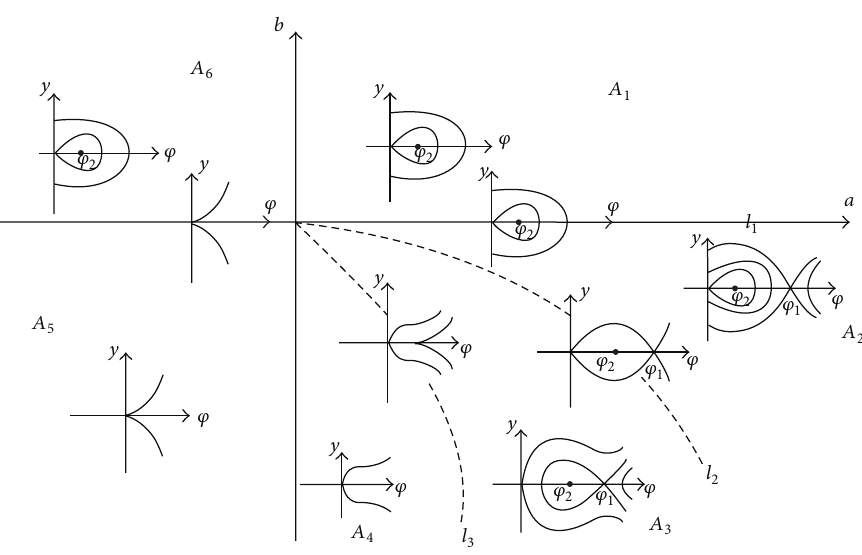
Figure 1: The bifurcation phase portraits of system (7) when 𝛿 > 0 .